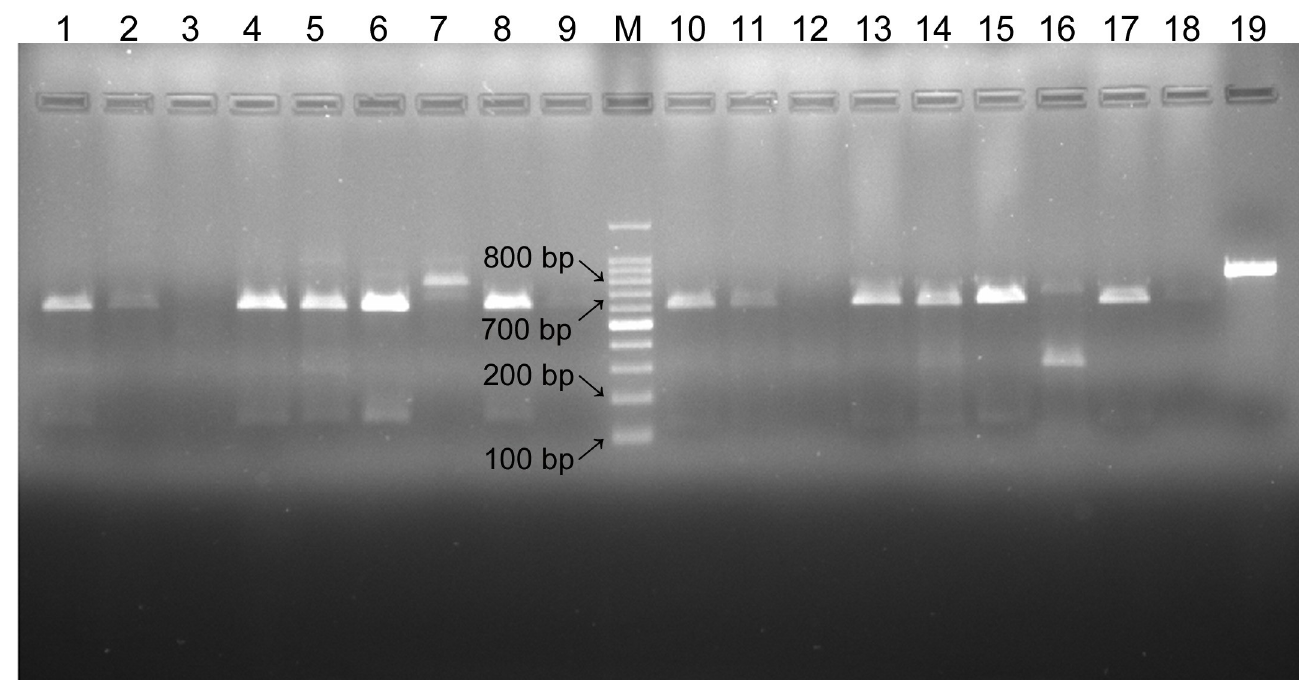
Fig 3. A typical result of Acc I and Hae III restriction enzyme analysis of DHPS gene PCR products. M: 100 bp DNA marker; Lanes 1–9: Results of Acc I enzyme digestion of DHPS gene amplification products; Lanes 10–18: Results of Hae III digestion of DHPS gene amplification products; Lane 19: Control (no